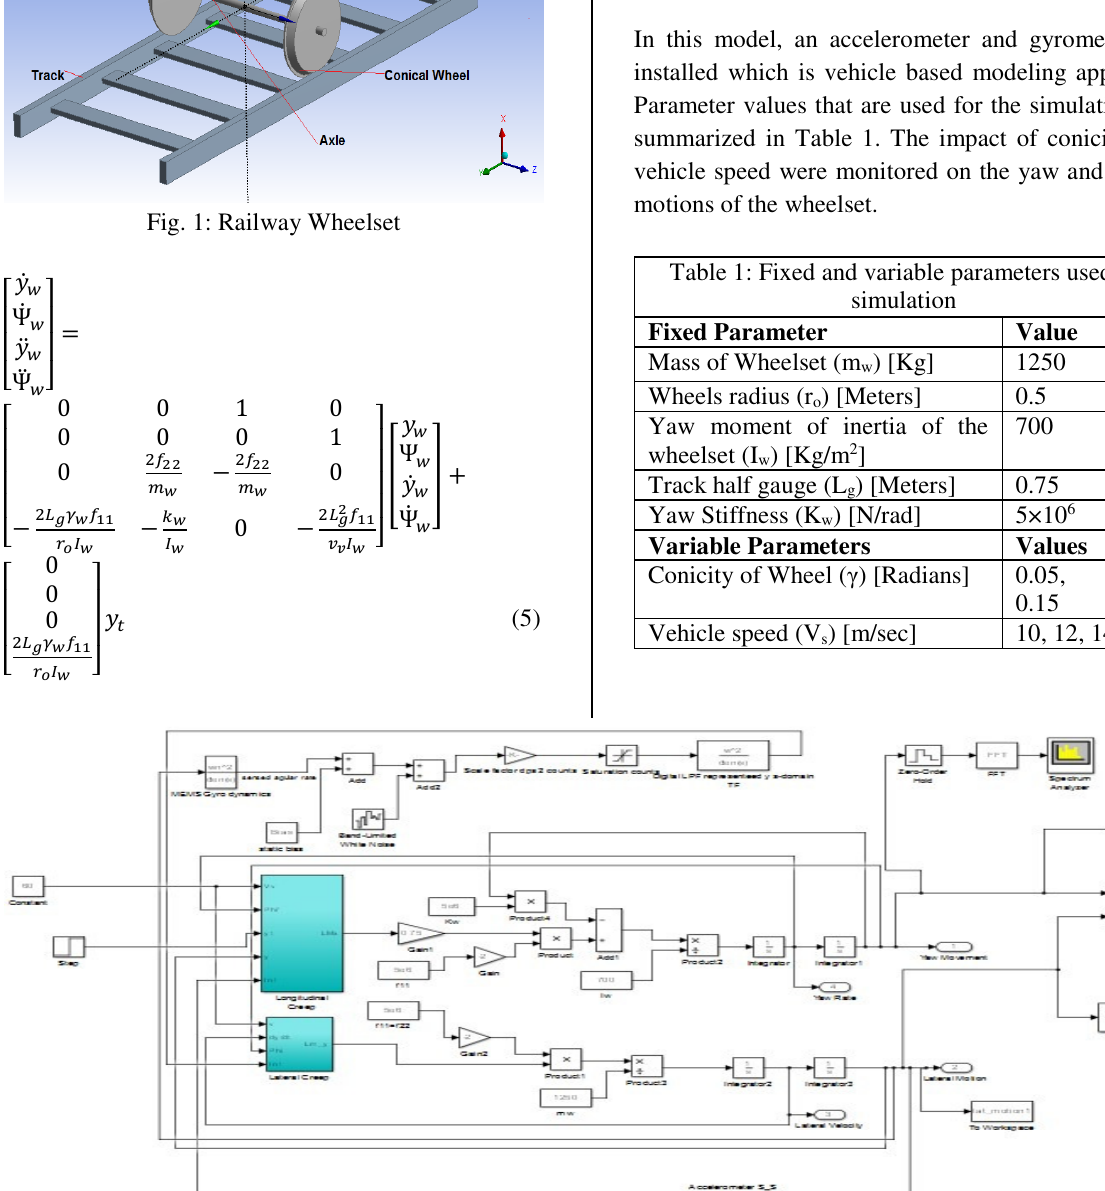
Fig. 2: Simulation model of railway wheelset with accelerometer and